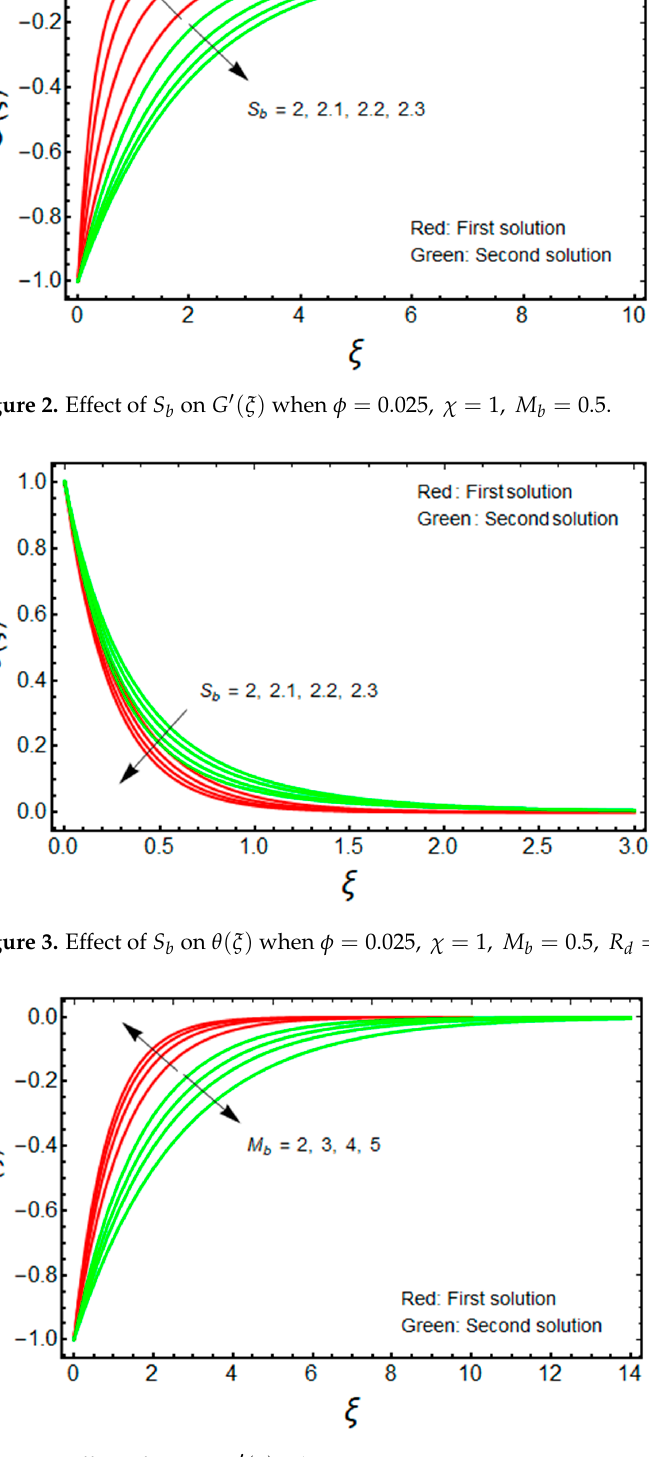
Figure 4. Effect of M b on G (cid:48) ( ξ ) when φ = 0.025, χ = 1, S b =